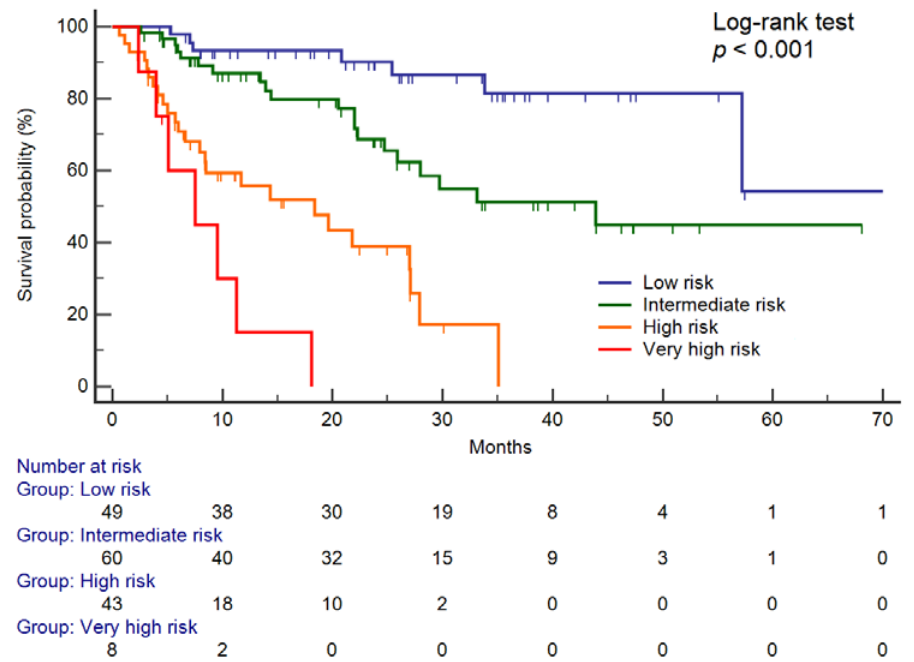
Figure 3. Survival curves according to risk categories. Based on the cut-off of 2.7 ng/mL for CYFRA 21-1, 20 ng/mL for AFP, and 200 mAU/mL for PIVKA-II, the low-risk category corresponded to no